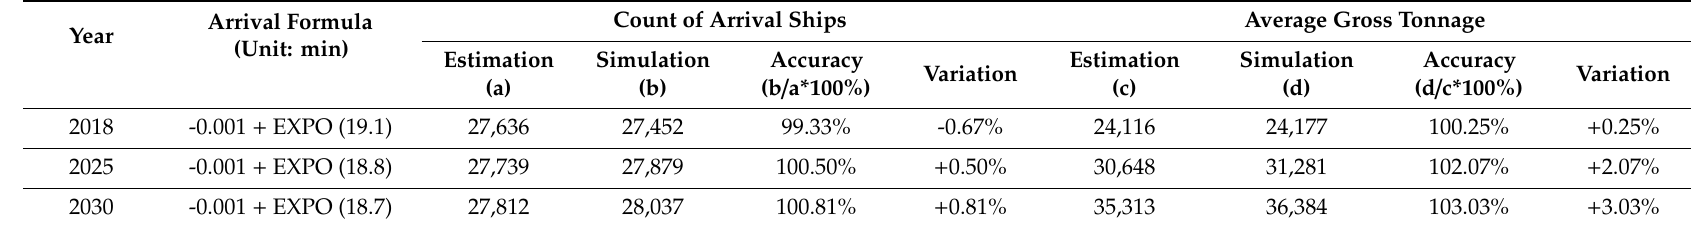
Table 18. Verification of Simulation Results.